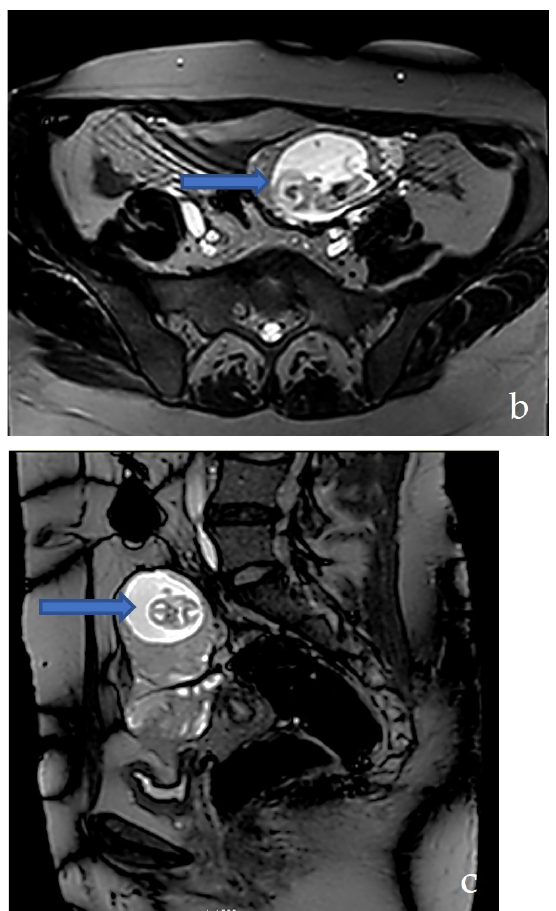
Figure 4. MRI examination: coronal T2-weighted ( a ), axial T2-weighted ( b ) sagittal T2-weighted ( c )—show the ectopic pregnancy on the left ovarian